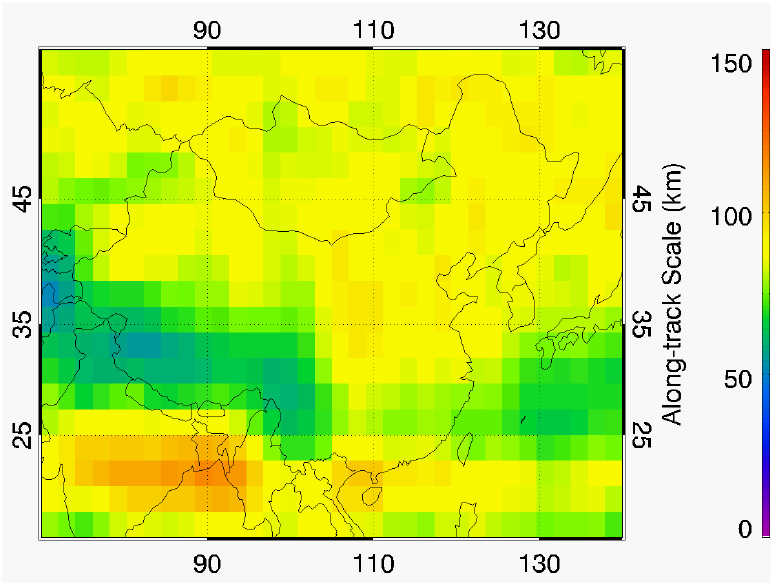
Figure 11. Distributions of cloud along-track horizontal scales over East Asia.